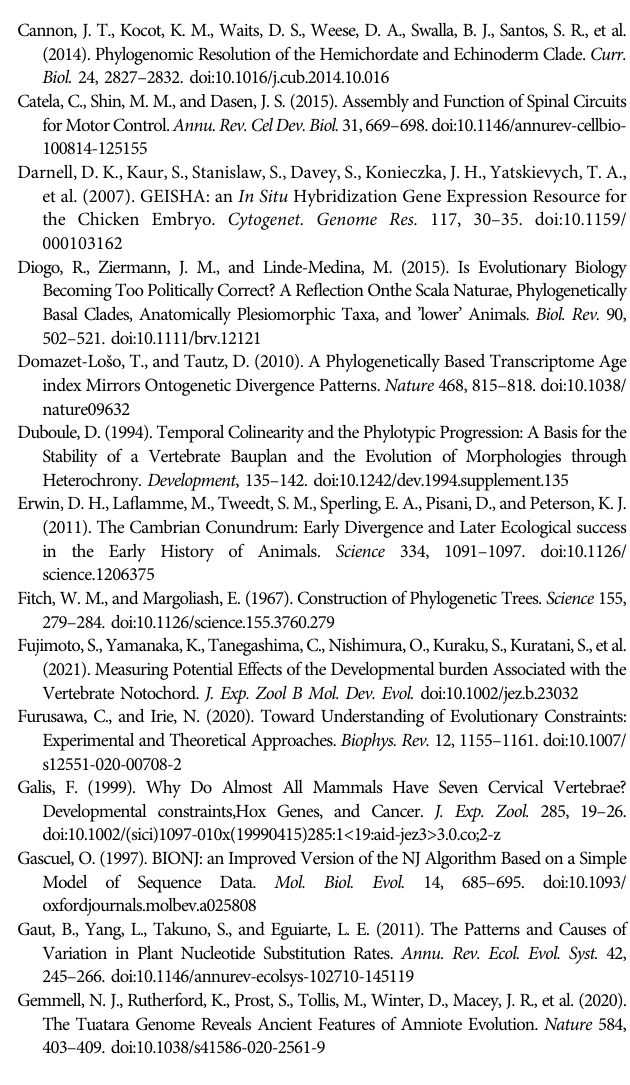
Supplementary Table S19 | 695 DCOs (derivedness-correlative ortholog-groups) showing negative correlations across six vertebrate species. Supplementary Table S20 | 230 negative DCOs across eight chordate